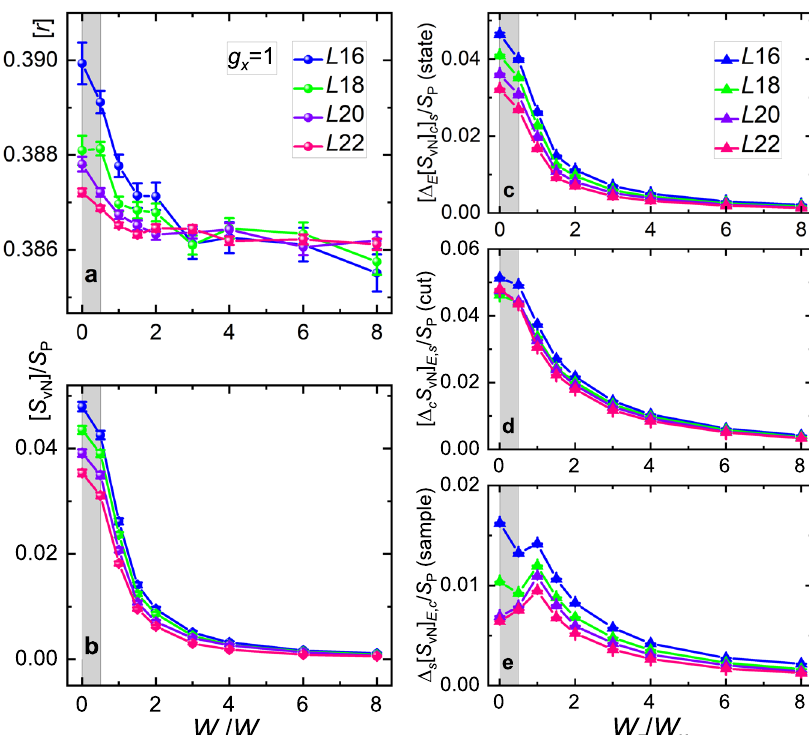
Fig. 4 Static diagnostics of the continuous cMBL-dMBL transition using the variance of S vN under OBCs. a , b Finite-size scaling analyses show that at fi xed g x ¼ 1 , [ r ] and [ S vN ]/ S P stay around r Poi and 0 under the adjustment of W z from cMBL toward dMBL. No discontinuity is W x observed. c The intrasample deviation of the entanglement entropy across the entirety of the eigenspectrum, ½ Δ E ½ S vN (cid:3) accompanying cut-to-cut and sample-to-sample parsings of this entropy deviation are plotted by d and e , respectively. The peak forming at W z ¼ 1 in e points toward a transition between cMBL (shaded) and W x